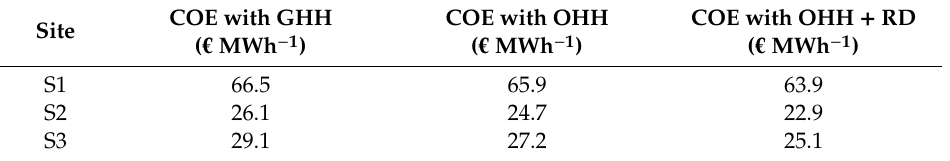
Table 7. COE by 80 m, optimal hub height, and optimal hub height + rotor diameter. COE with Site